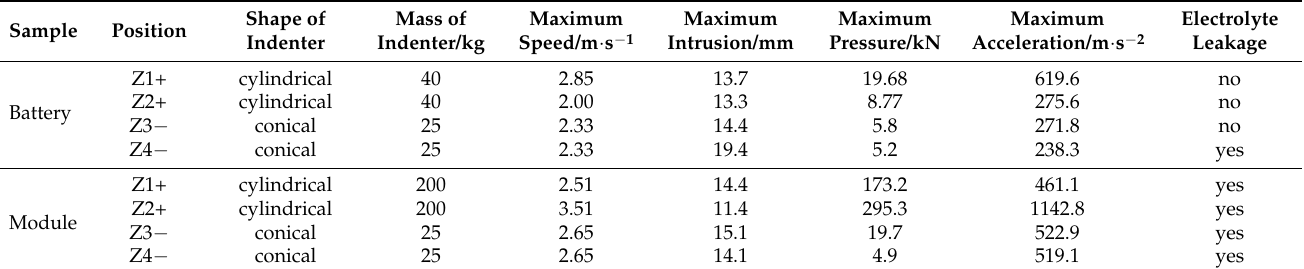
Table 2. Test results under different impact conditions.